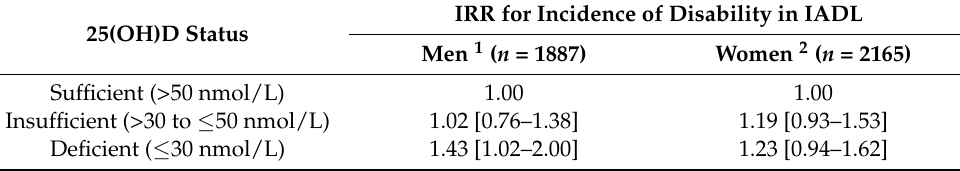
Table 3. Final adjusted Poisson regression models for incidence of IADL disability during a 4-year follow-up, ELSA Study